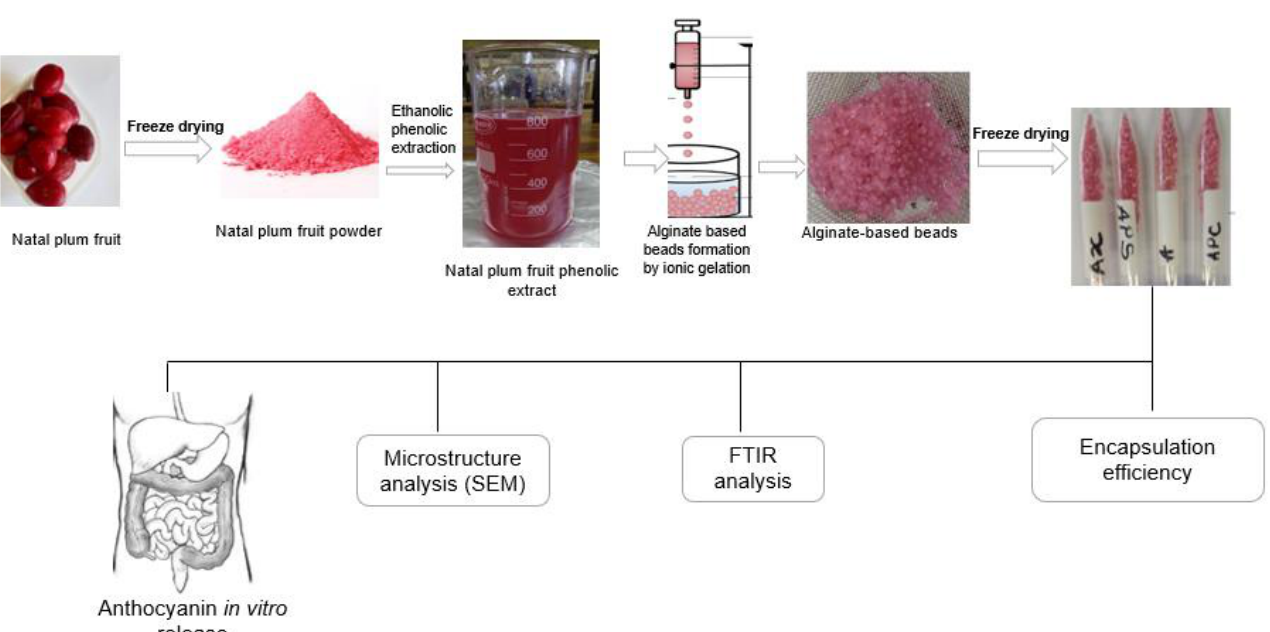
Figure 1. Schematic representation of the development of alginate-based beads and analysis .